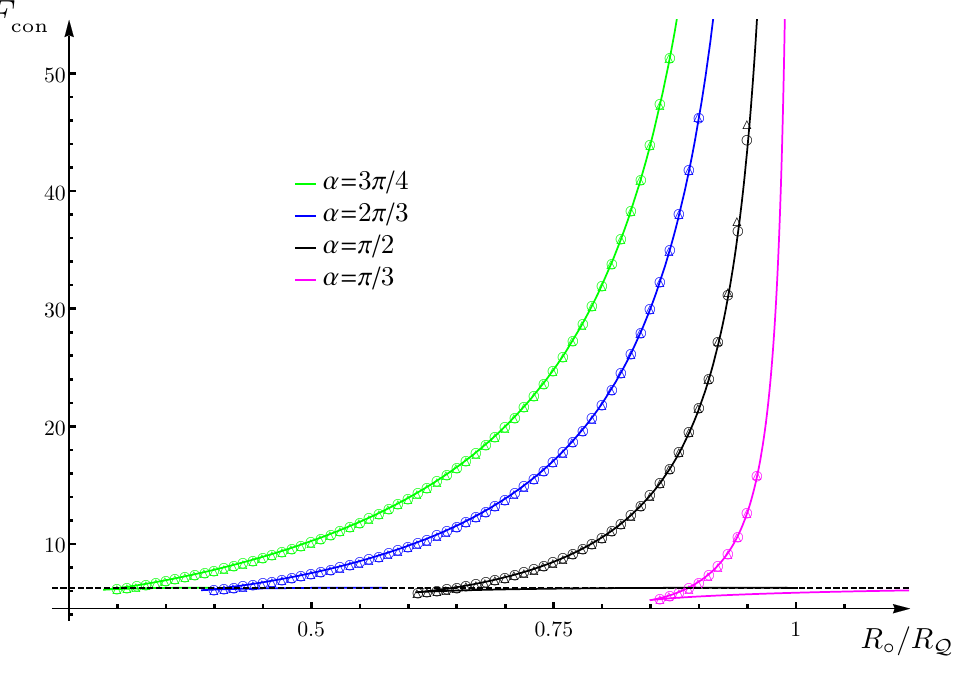
Figure 9 . The subleading term F for the extremal surfaces ^ (cid:13) con intersecting orthogonally Q con A in terms of the ratio R (cid:14) =R Q , for some values of (cid:11) . The allowed con(cid:12)gurations have R (cid:14) =R Q < 1. The solid curves have been obtained by combining the analytic expressions (4.9) and (4.13). The horizontal dashed line corresponds to the value of the subleading term of the hemisphere ^ (cid:13) dis , A i.e. F A = 2 (cid:25) . The data points are the numerical values obtained through Surface Evolver. The ones below the horizontal dashed line correspond to extremal surfaces that are not global